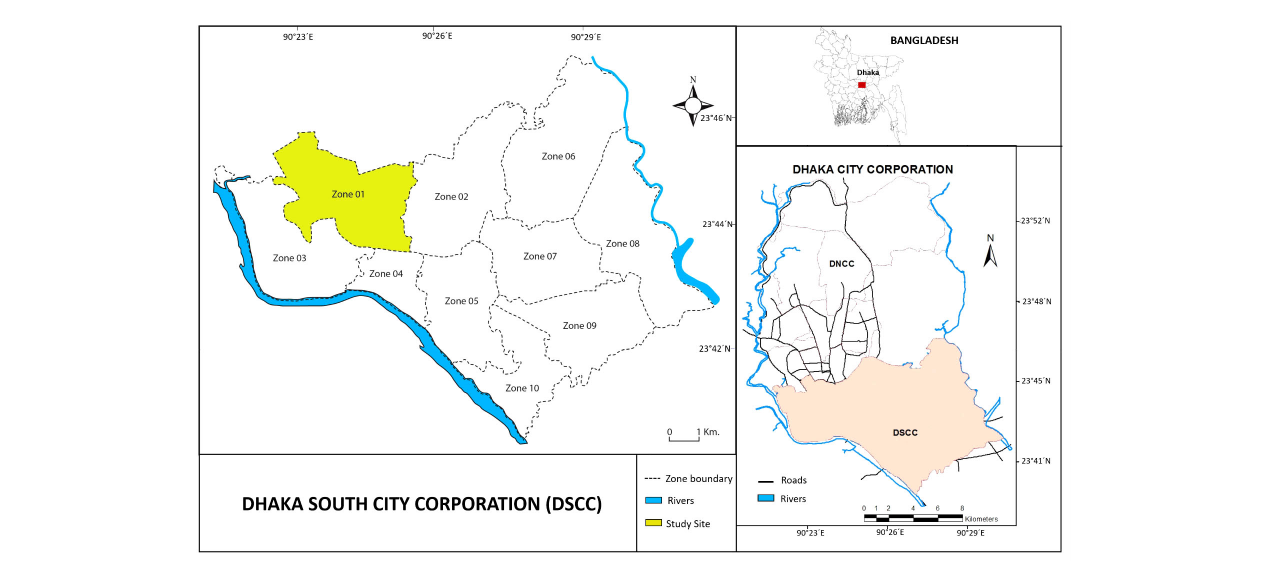
Fig. 1 . Location of the study area.